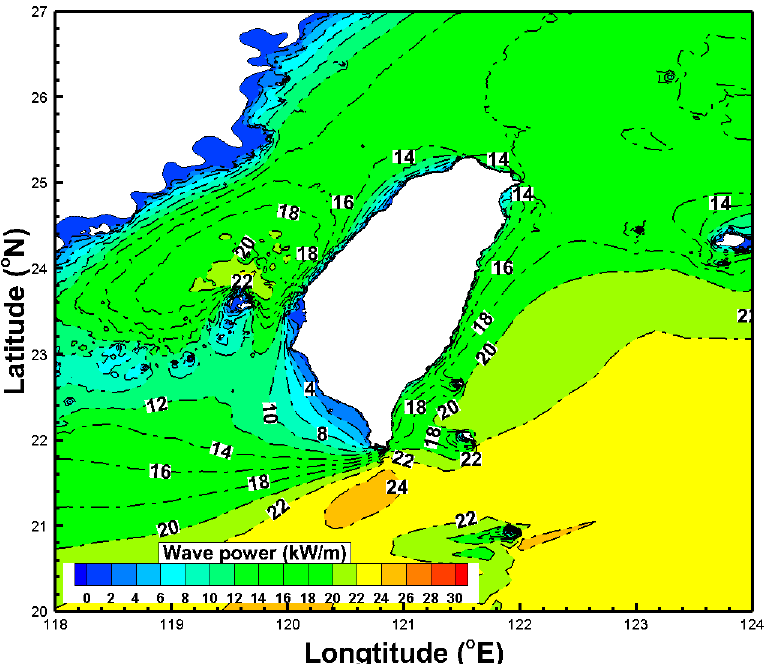
Figure 9. Spatial distribution of the wave power in the offshore waters of Taiwan averaged over 1991 to 2010.